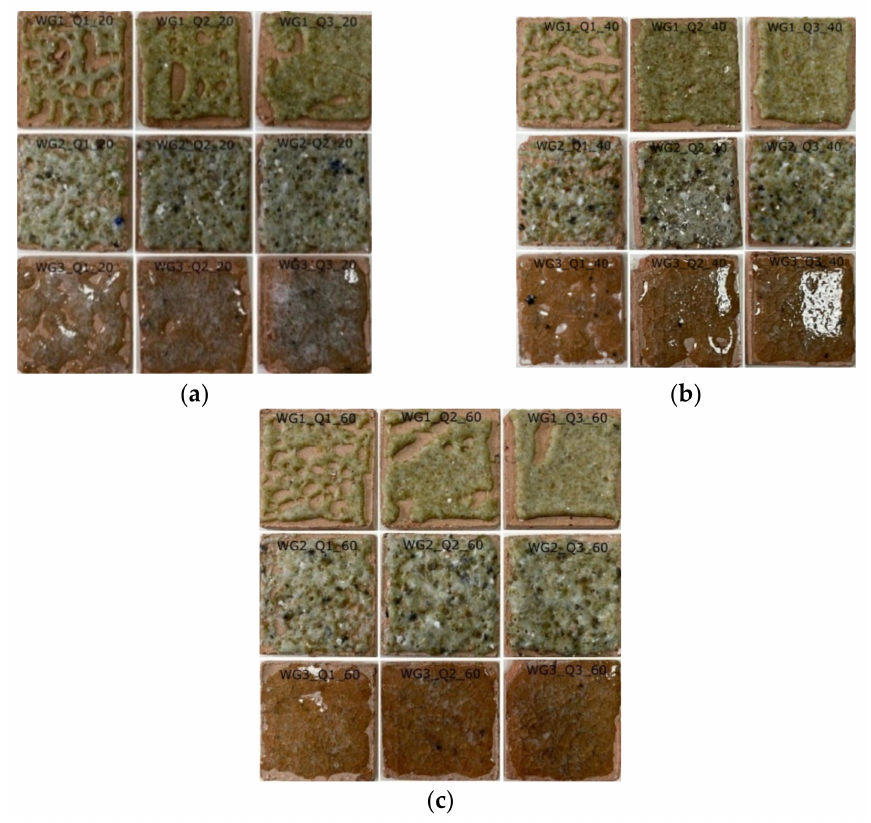
Figure 4. Tiles specimens fired at 1000 ◦ C during ( a ) 20 min, ( b ) 40 min, and ( c ) 60 min. In each figure, the first row shows WG1, the second row WG2, and the third row WG3 coated samples respectively. In addition, in each figure, the first column shows Q1 samples, the second column shows Q2 samples, and the third column shows Q3 samples according to Table